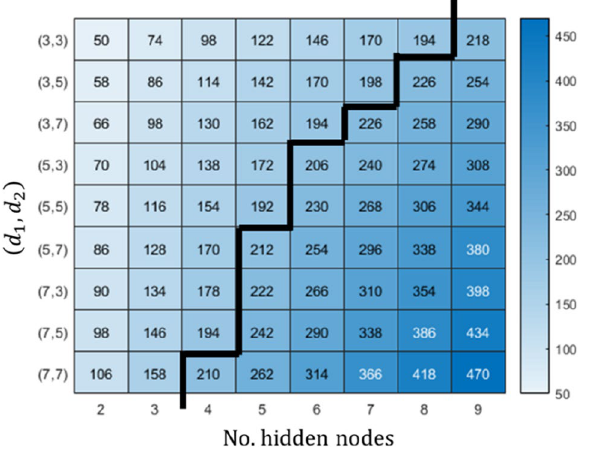
Figure 4. Degree of freedom of NARX-NN for a designated boundary condition imposed on delay units; d 1 and d 2 . The number of hidden nodes of the network is restricted to nine corresponds to N = 200.